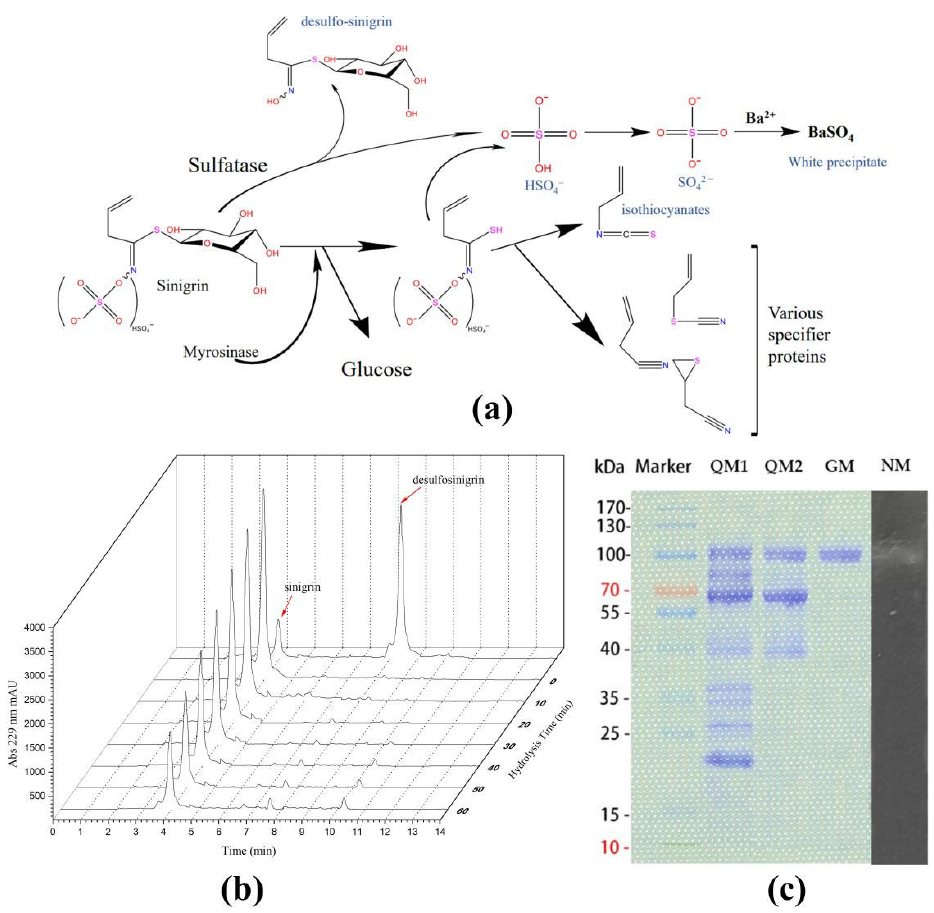
Figure 4. The molecular weight of Shewanella baltica Myr-37 myrosinase is approximately 100 kDa. ( a ) Main pathways of sinigrin metabolism. ( b ) High-performance liquid chromatography analysis of desulfo-sinigrin during the enzymatic hydrolysis. The crude enzyme (50 μ g) was added to the mixture of sinigrin (2 mg/mL) in PBS to make a final volume of 1 mL. ( c ) Results of the SDS-PAGE analysis for the purification of Smyr37 and the Native-PAGE analysis of Smyr37. Lanes: QM1, ion exchange first run; QM2, ion exchange second run; GM: gel filtration; NM: Native-PAGE analysis. Table 1. Purification of Shewanella baltica Myr-37 myrosinase. Purification